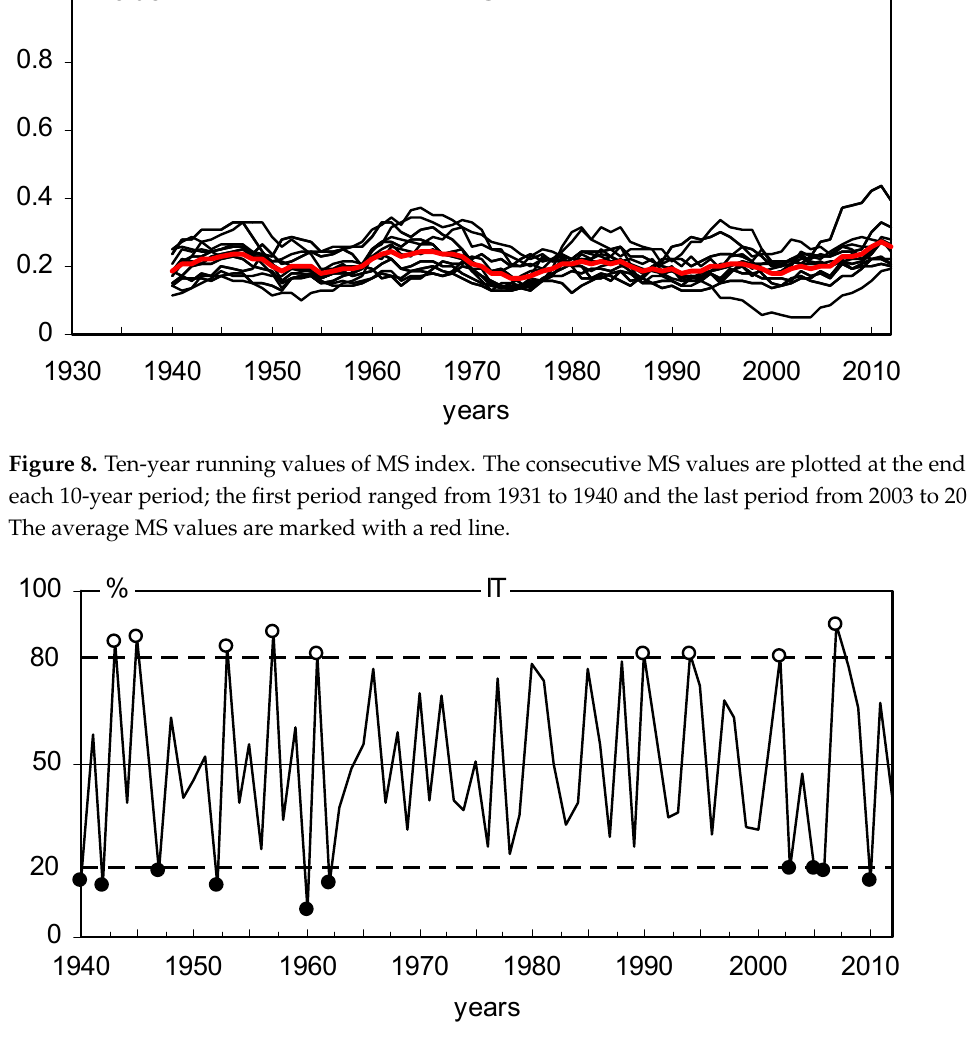
Figure 9. Regional chronology of IT indices and positive (white dots) and negative (black dots) pointer years.